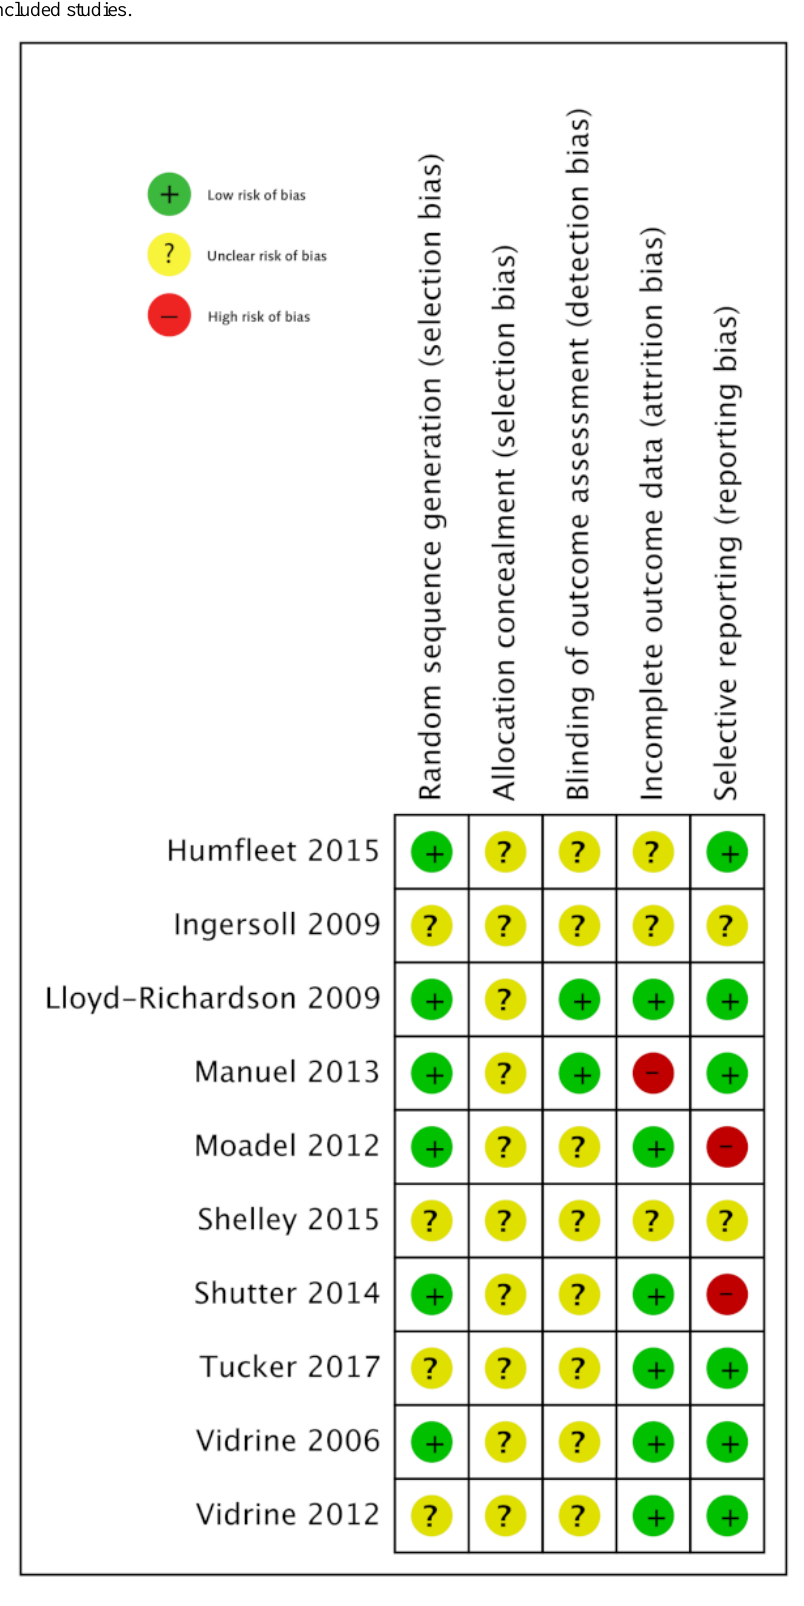
Figure 4. Risk of bias in included